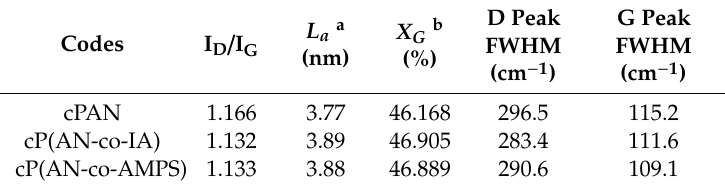
Table 3. The detailed peak parameters of cPAN, cP(AN-co-IA), and cP(AN-co-AMPS) nanofibers obtained from the fitting Raman